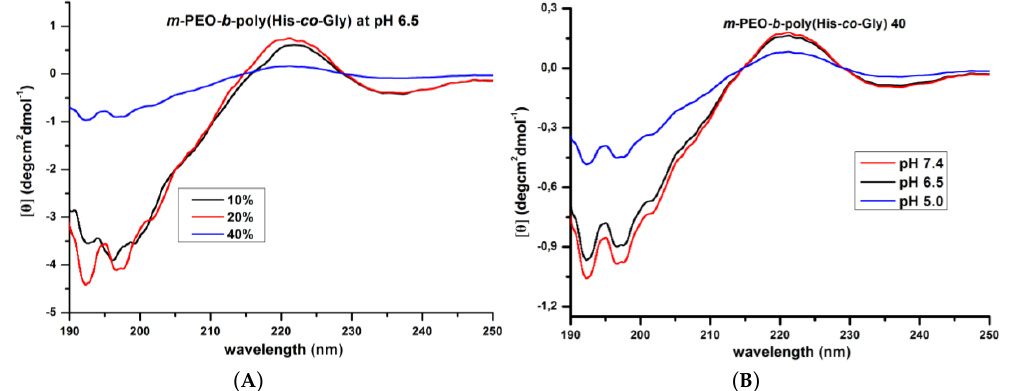
Figure 6. ( A ) CD of m- PEO- b -poly(His- co -Gly) with different Gly to His molar ratios at pH 6.5; ( B ) CD of m- PEO- b -poly(His- co -Gly) with 40% molar ratio of Gly residue to His residue as a function of pH.